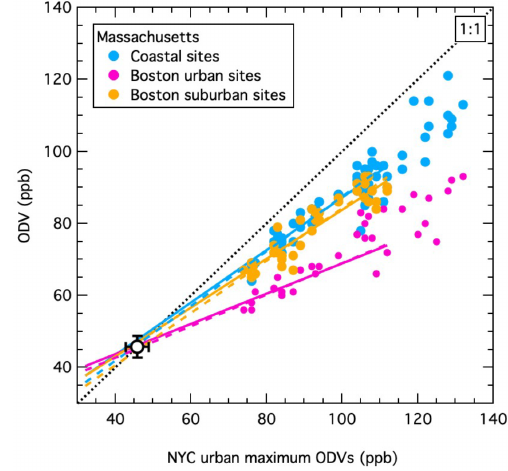
Figure 12. Correlation between the ODVs from three sets of Mas- sachusetts sites and the maximum ODVs recorded in the New York city urban area. Lines of corresponding color show ordinary lin- ear regression (solid) and reduced major axis regression with equal weighting (dashed) fits of the correlated data sets for the ODVs recorded in 2000–2017. The black symbol shows the mean US background ODV derived from the exponential fits to the ODV time series, and the dotted line indicates the 1 : 1